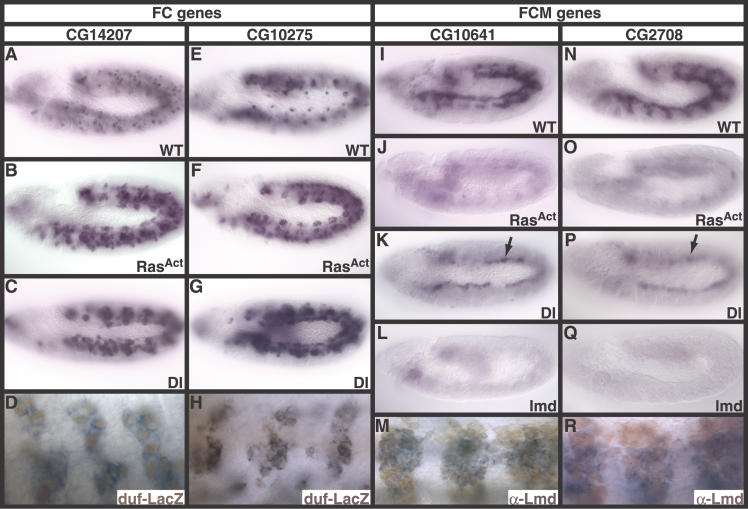
Empirical Validation of Predicted FC and FCM GenesCG14207 (A–D) and CG10275 (E–H) are representative FC genes identified in the present work with meta-analysis ranks of 6 and 11, respectively (Figure 3B and Table S1). RNA in situ hybridization shows that each is normally expressed in a characteristic subset of somatic myoblasts (A and E) and in an expanded population in embryos in which Ras is ectopically activated (B and F) or that are mutant for Dl (C and G). Staining of in situ–hybridized embryos with the founder marker duf-lacZ (orange nuclei: D and H) reveals extensive coexpression. CG10641 (I–M) and CG2708 (N–R) are representative FCM genes ranked in the meta-analysis as 38 and 23, respectively. In wild-type embryos (I and N), they are expressed in the majority of somatic and visceral myoblasts. This expression is largely lost in activated Ras embryos (J and O) and in the somatic mesoderm of Dl mutant embryos (K and P), although the latter retain expression in the visceral mesoderm (arrows). Expression of these genes is lost in lmd mutant embryos (L and Q), and is normally restricted to a subset of Lmd-expressing cells (orange nuclei: M and R).